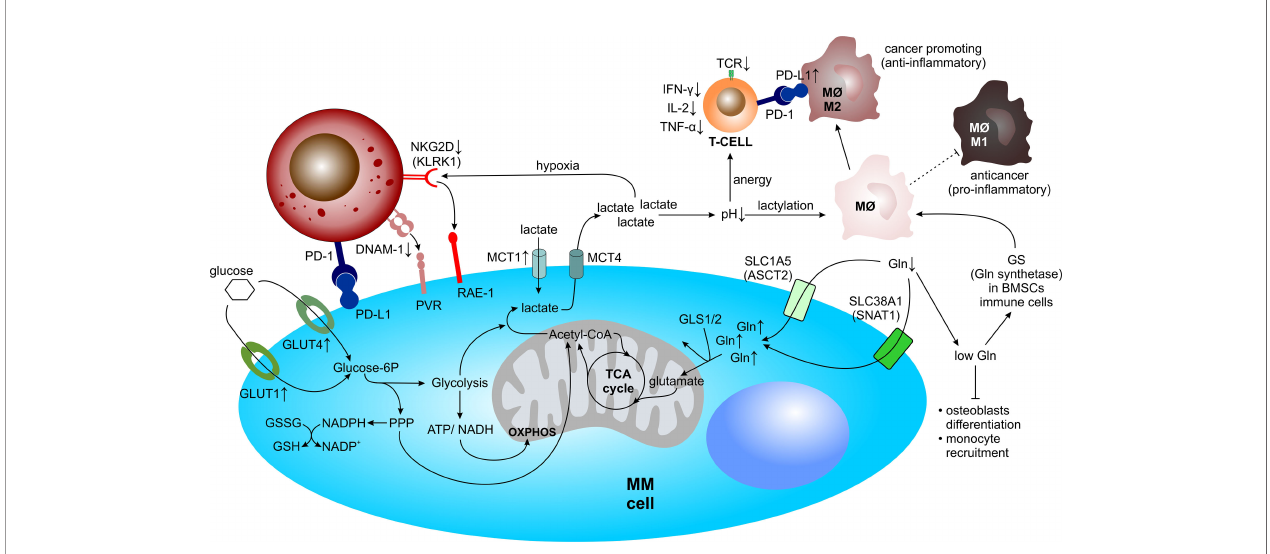
FIGURE 4 | Metabolic reprogramming of MM within the TME. Within the TME, MM cells undergo metabolic adaptations and simultaneously drain their microenvironment of vital resources, such as glucose for glycolysis and/or the pentose phosphate pathway and glutamine for glutaminolysis, allowing for rapid cell proliferation. Concomitantly, metabolic reprogramming shapes the TME towards a hypoxic, acidic, and nutrient depleted milieu, thereby negatively in fl uencing anti-MM immune cell performance. Acetyl- CoA, acetyl-coenzyme A; ATP, adenosine triphosphate; BMSC, bone marrow mesenchymal stromal cell; DNAM-1, DNAX accessory molecule-1; Gln, glutamine; GLS, glutaminase; GLUT, glucose transporter; GS, glutamine synthetase; GSH, glutathione (reduced); GSSG, glutathione (oxidized); IFN- g , interferon- g ; IL, interleukin; KLRK1, killer cell lectin like receptor K1; M F , macrophage; MM, multiple myeloma; MCT, monocarboxylate transporter; NAD(P)+/H, nicotinamide adenine dinucleotide (phosphate) oxidized/reduced; NK, natural killer cell; OXPHOS, oxidative phosphorylation; PD-1, programmed cell death protein 1; PD-L1, programmed cell death 1 ligand 1; PPP, pentose phosphate pathway; PVR, poliovirus receptor; RAE-1, ribonucleic acid export-1; SLC1A5, solute carrier family 1 member 5; SLC38A1, solute carrier family 38 member 1; TCA, tricarboxylic acid; TCR, T cell receptor; TNF- a , tumor necrosis factor- a